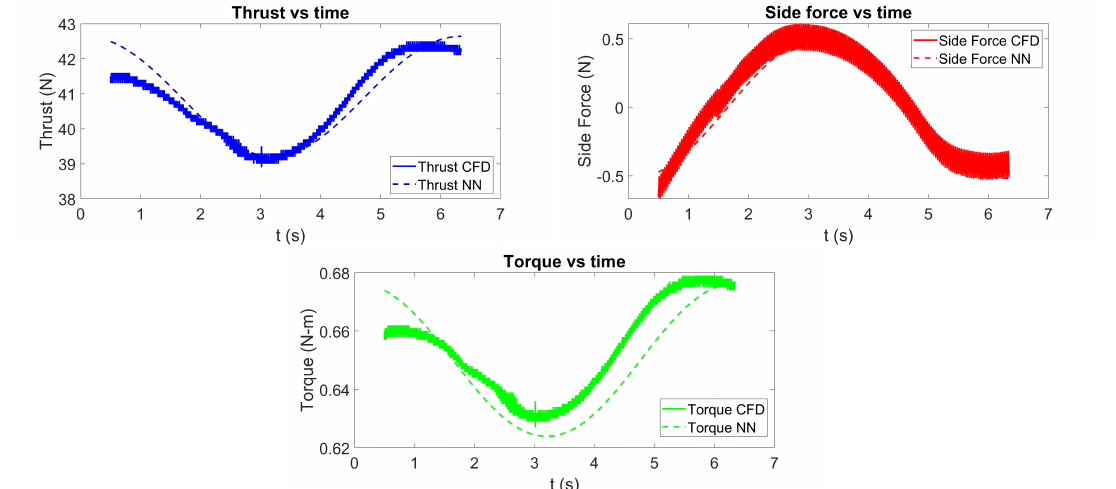
Figure 16. Behind condition neural network predictions of thrust, side force, and torque for Test 1 as a function of